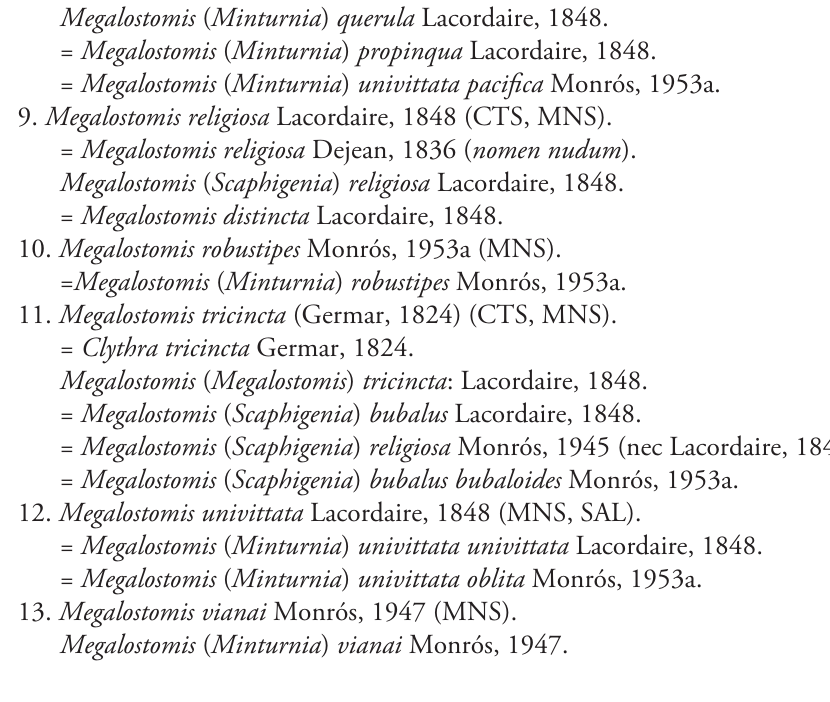
Fig. 20 Themesia Lacordaire 1848: 517-518; Chapuis 1874: 138; Jacoby and Clavareau 1906: 62; Clavareau 1913: 77; Guérin 1943: 30; Monrós 1953a: 130; Moldenke 1970: 12. Type species. Themesia auricapilla (Germar, 1824), designated by Monrós 1953a: 130. Diagnosis. This genus is close to Coscinoptera , from which it can be separated by its unicolored metallic green/blue coloration (except in T. costaricensis and T. lacord- airei , not present in Argentina) and by its distinct body shape. Eyes large, non-emar- ginate and distinctly protruding; elytra glabrous without distinct punctation pattern, epipleurae reduced; pygidium flat; antennomere IV much smaller than V, not clavate; ventrites densely